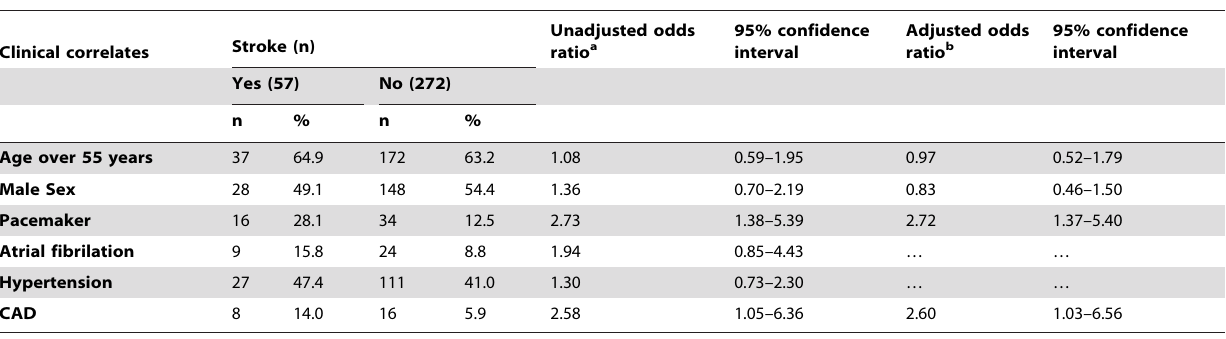
Table 4. Stroke Correlates in Chagasic Patients.